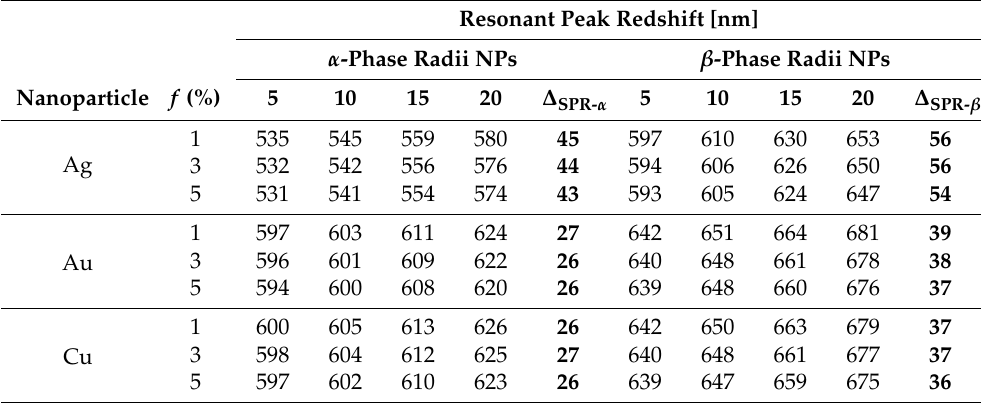
Table 1. Centered resonant peak values at different phases of MoO 3 thin films doped with different nanoparticles at different volume filling fractions ( f ).